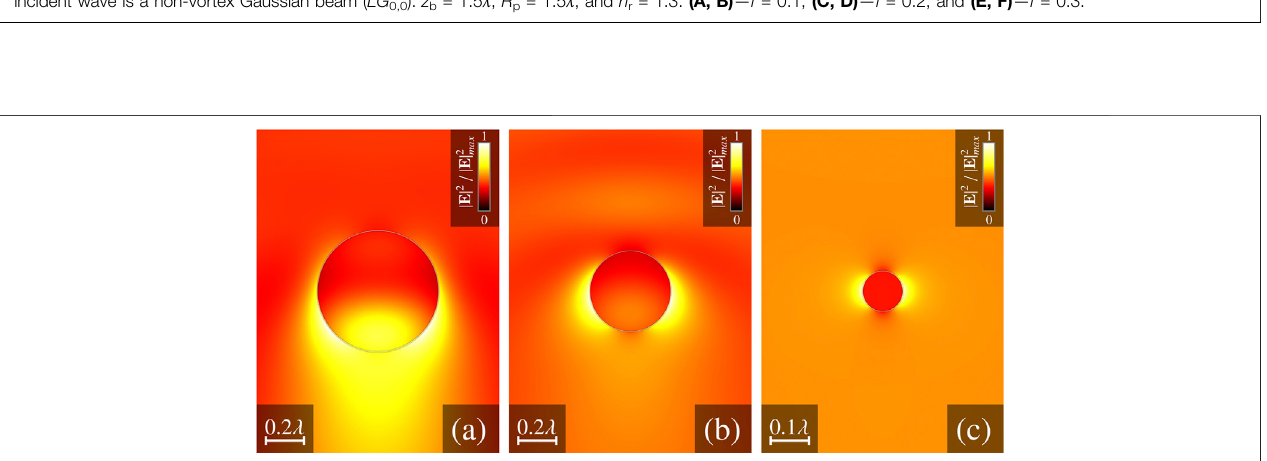
FIGURE3| Diffractiononthedielectricsphericalparticle:near- fi eldintensitydistributionsinthe x - z plane.Theincidentwaveisavortex-freeGaussianbeam( LG 0,0 ). f (cid:2) 0.02 and n r (cid:2) 1.3. (A) — R p (cid:2) 0.3 λ , (B) — R p (cid:2) 0.2 λ , and (C) — R p (cid:2) 0.05 λ .